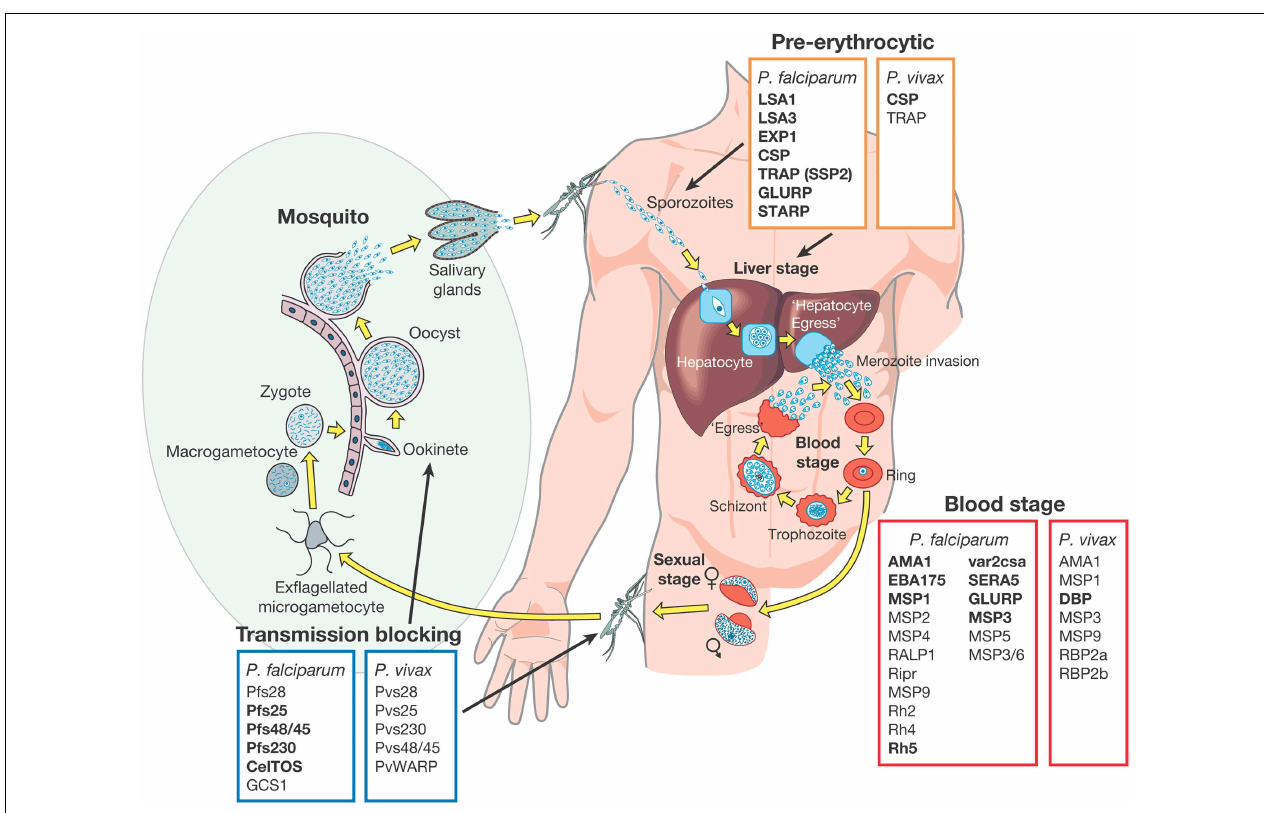
those that are currently being evaluated in pre-clinical trials or have entered at least Phase 1 clinical trials according to theWHO malaria vaccine rainbow tables (50).The P. vivax latent stages known as “hyponozoites” are not shown but these occur in the liver